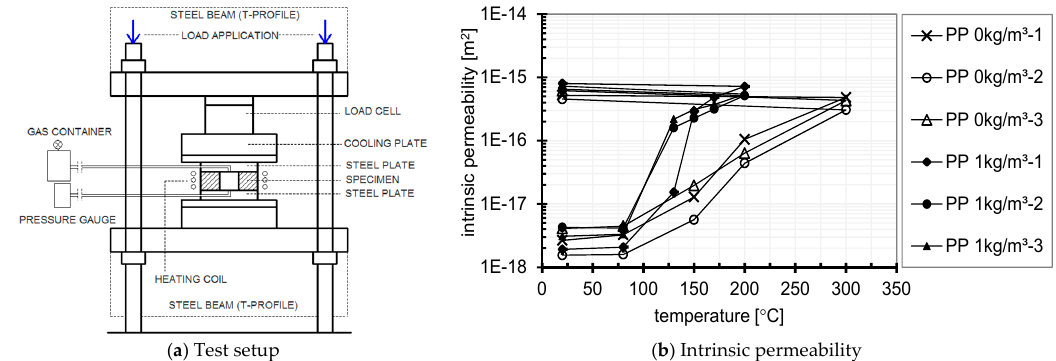
Figure 2. Permeability of concrete without and with micro PP fibres as a function of temperature, data from [2]. (Note: 1E-18 refers to 1.0 × 10 − 18 ).